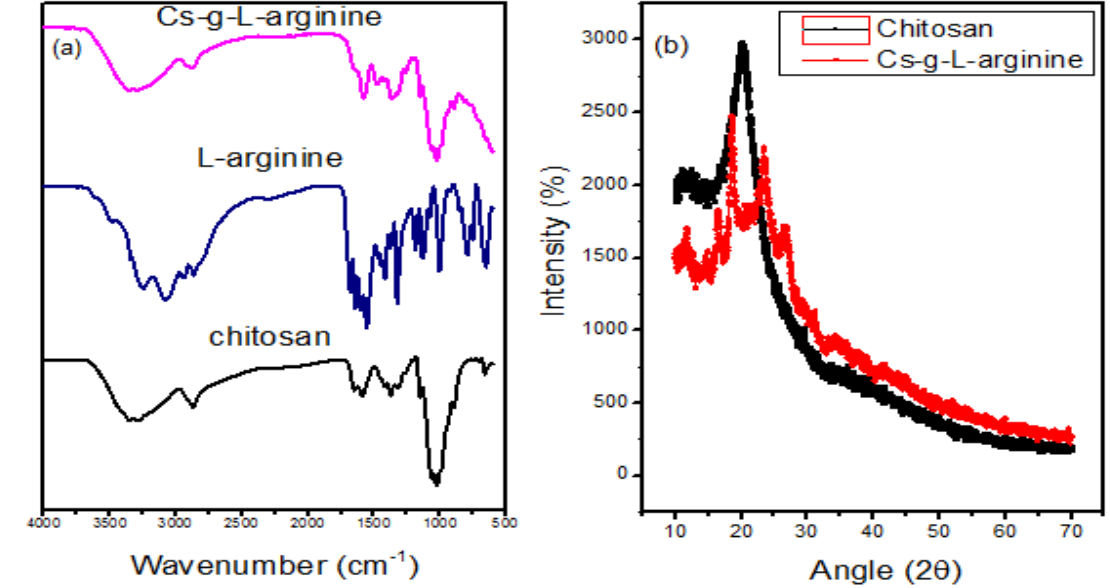
Figure 2. ( a ) Attenuated Fourier Transform Infrared Spectra of Chitosan, L-arginine, and Cs-g-L- arginine ( b ) X-ray Diffraction Spectrum.